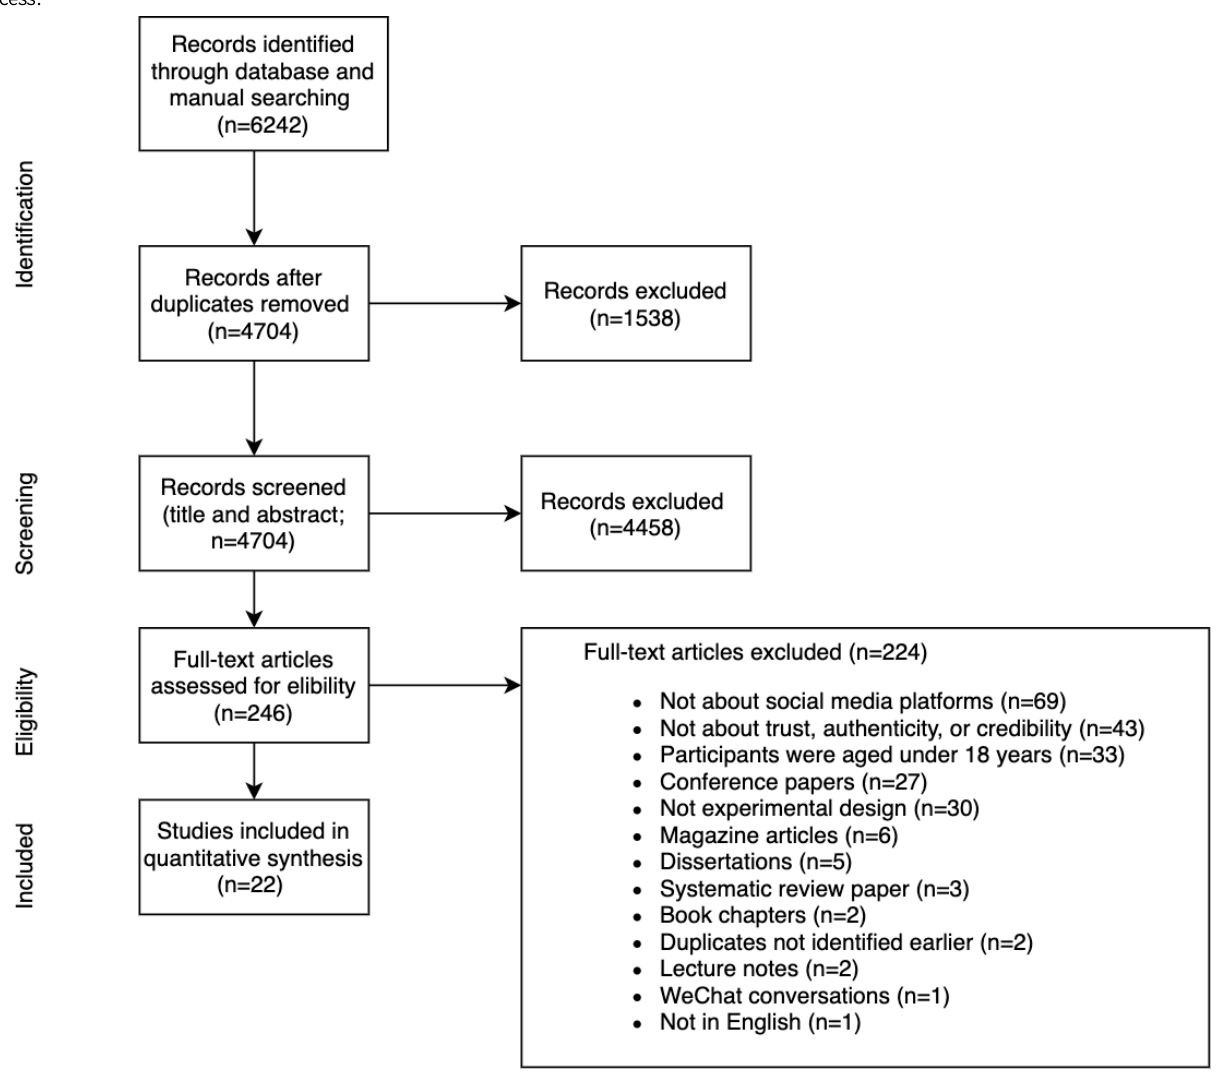
Figure 1. Preferred Reporting Items for Systematic Reviews and Meta-Analyses for Scoping Reviews flow diagram of the search and study selection